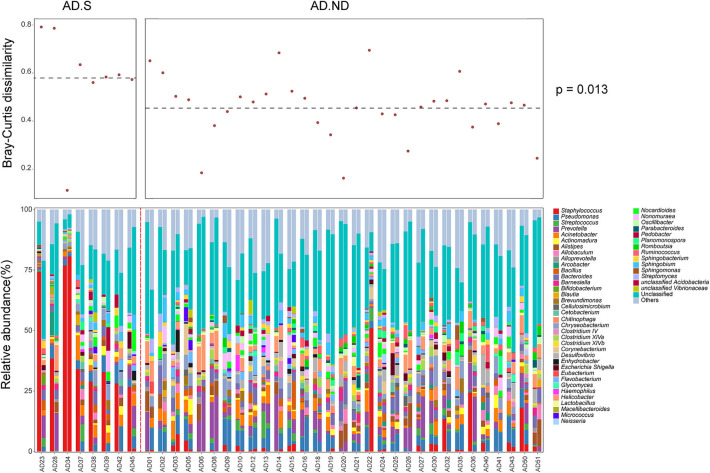
Cutaneous microbiota in AD patients before and after therapy. In the upper panel, the Bray-Curtis distance was calculated for the skin microbiota changes in each AD patient. In the lower panel, the skin microbiota compositions were analyzed in 39 AD patients before and after clinical treatment. The red dotted line was used to separate patients in the AD.S group and AD.ND groups.